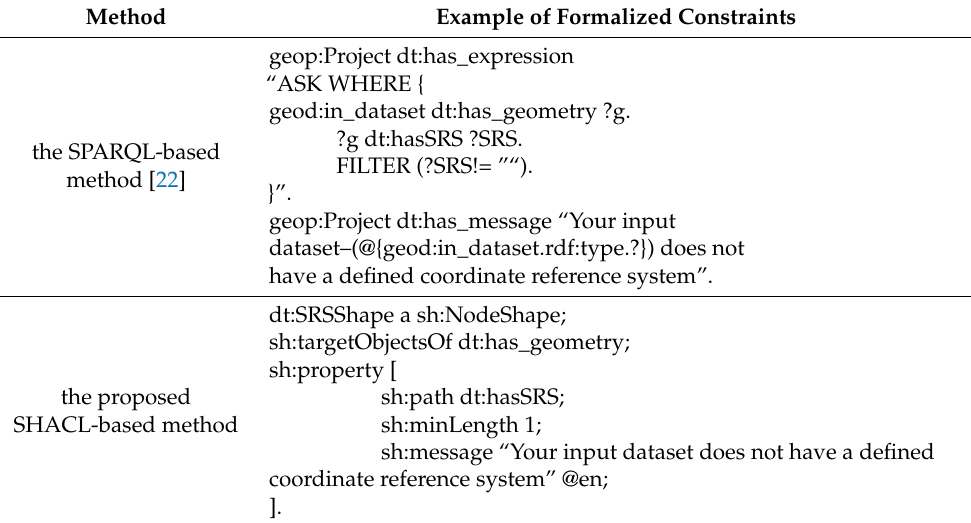
Table 8. Comparison of constraints formalized based on SPARQL and